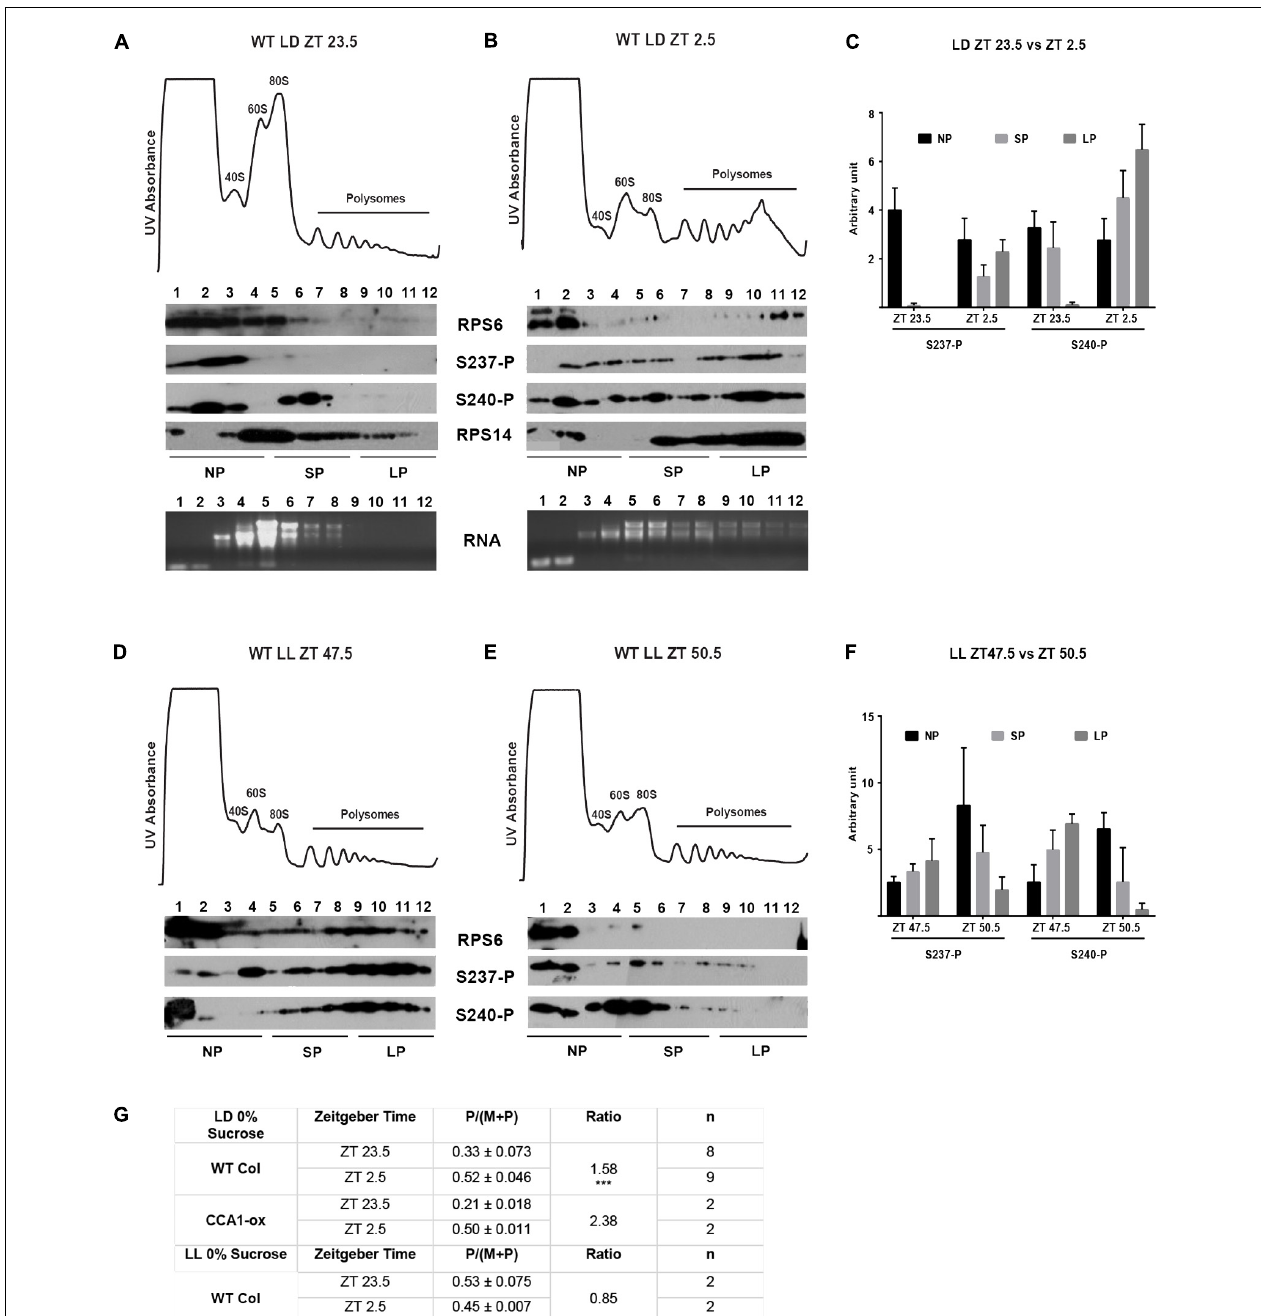
FIGURE 8 | RPS6-P in polysomes. Twelve-day old wild-type seedlings were grown under the indicated light conditions (0% sucrose), and harvested at ZT23.5 (end of night) and ZT2.5 (morning) followed by sucrose gradient fractionation of total cell extracts. In the UV absorption profiles 40S, 60S, 80S ribosomes as well as polysomes are labeled. Equal volumes of each gradient fraction were probed for S237-P and S240-P and for total RPS6. (A–C) Wild-type seedlings grown in a long-day light-dark cycle and harvested at ZT23.5 (A) and ZT2.5 (B) . As controls, the fractions were additionally probed for RPS14 and RNA extracted from the fractions was run on a gel to show the distribution of the ribosomal RNA. Note that for the RPS6 antibody, it appears that exposure of RPS6 to the high sucrose concentration in the gradient results in a drop in affinity to the antibody when the samples are analyzed. (C) Immunoblot signals for S237-P and S240-P were quantified using ImageJ and were pooled into bins for non-polysomal material (fractions 1–4), small polysomes (fractions 5–8, including monosomes), and large polysomes (fractions 9–12). Data in (C) are from 6 biological replicates. (D–F) Same as (A–C) , but seedlings were shifted to continuous light on day 11 at ZT0 and harvested at the equivalent times (end of subjective night, subjective morning). (G) Table displaying the polysome/(monosome + polysome) (P/(M + P)) ratios and the ratio of ZT 23.5 to ZT 2.5 under LD and ZT 47.5 to ZT 50.5 under LL. Standard deviation was calculated for the P/(M + P) ratios and ∗∗∗ indicates p < 0.001 in a t